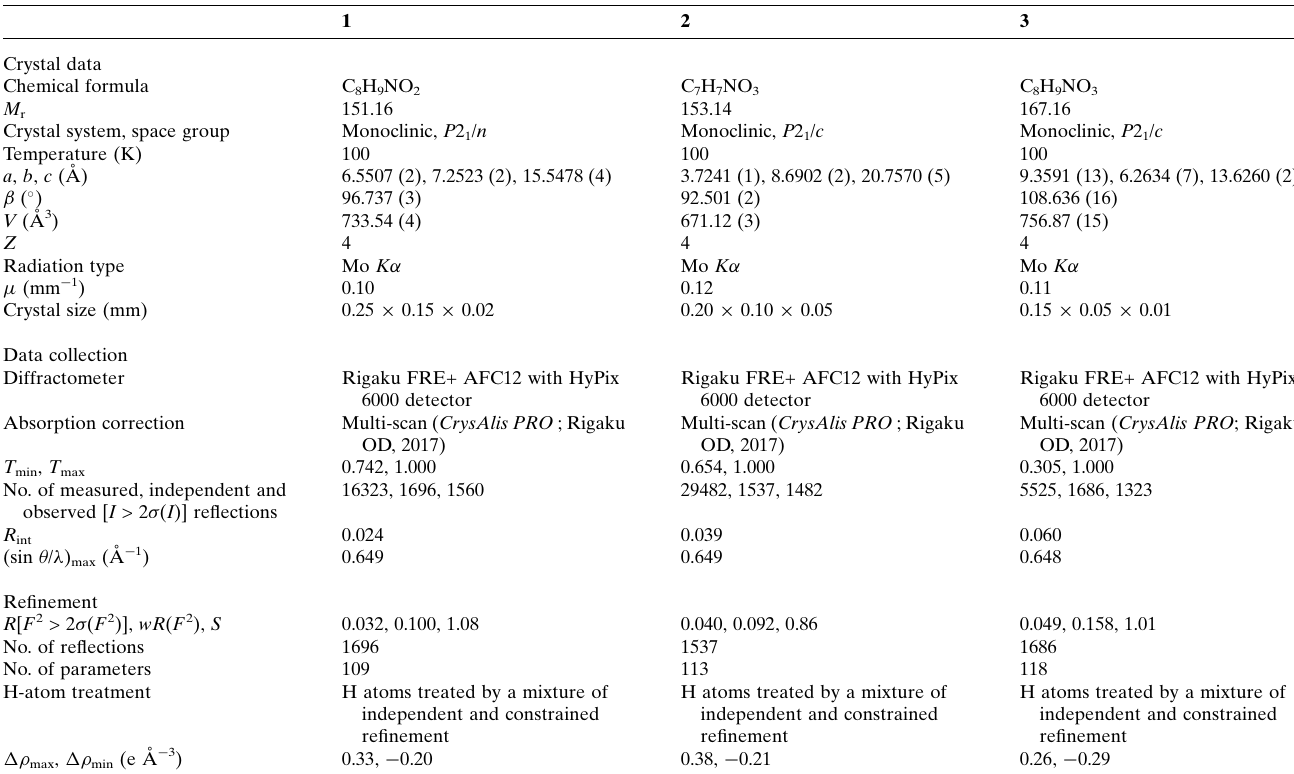
Table 5 Experimental details.